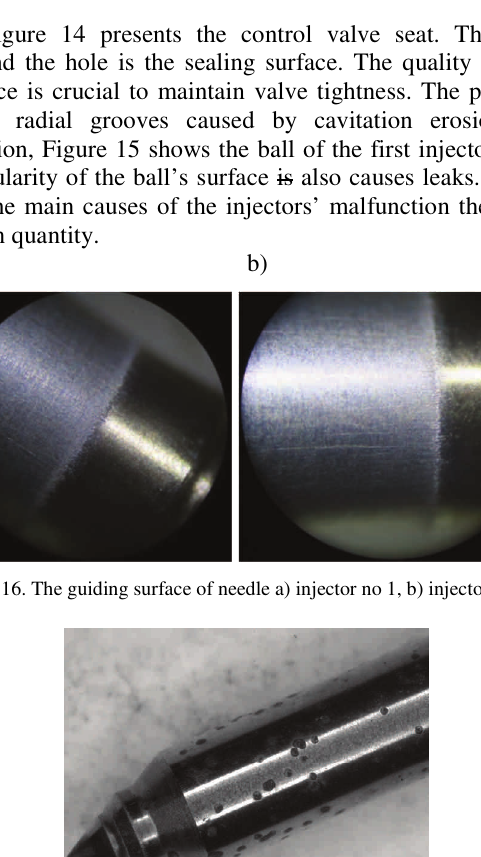
Fig. 15. Damage of the valve ball